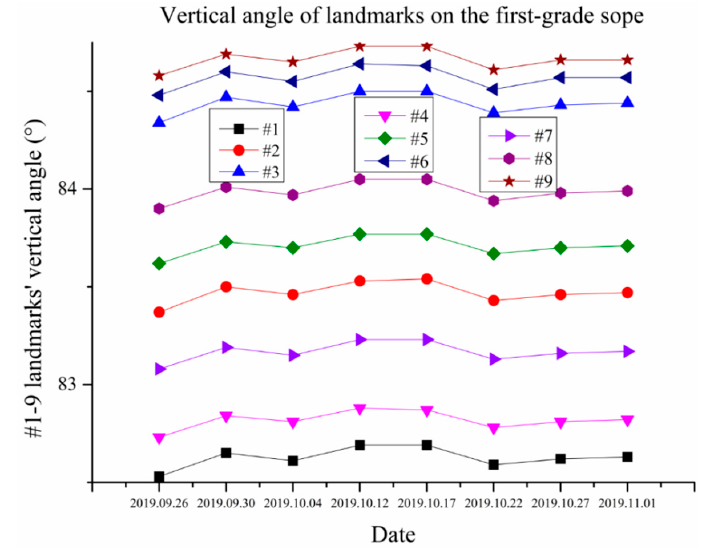
Figure 15. Vertical angle change charts of landmarks on the first-grade slope.